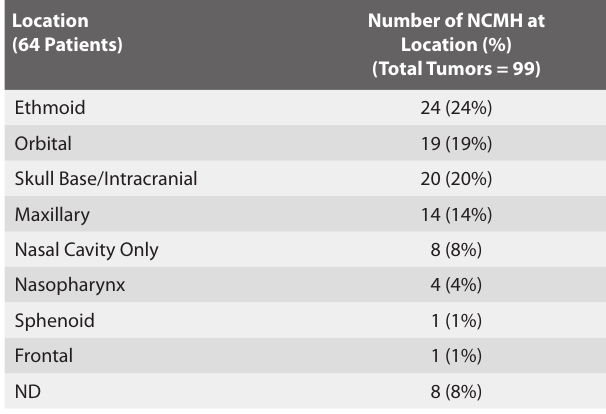
Table 3. Location of nasal chondromesenchymal hamartomas in pub- lished and unpublished